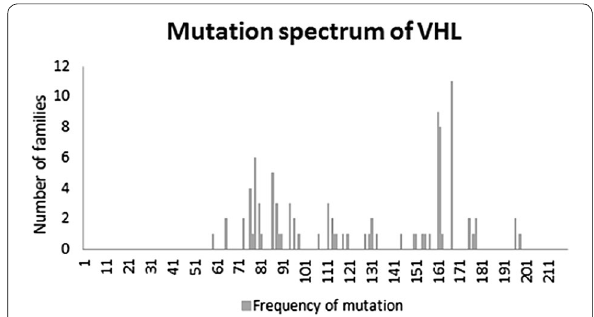
Fig. 1 Frequency of point mutations in the von Hippel–Lindau ( VHL ) gene in an East Asian